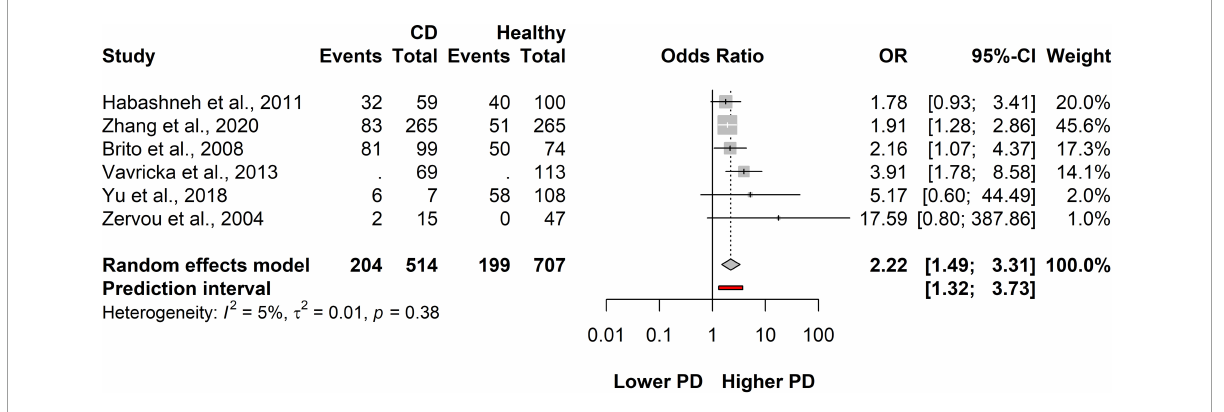
FIGURE3 Forest plot showing the association between Crohn’s disease (CD) and periodontitis.